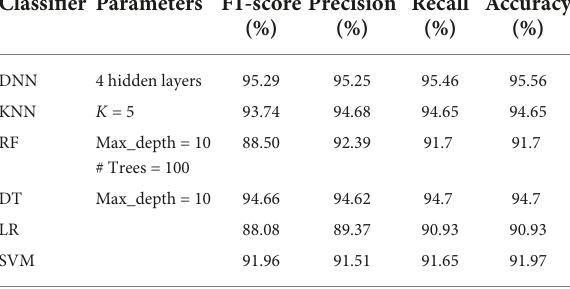
TABLE 6 Performance analysis of classifiers on DS2 dataset.